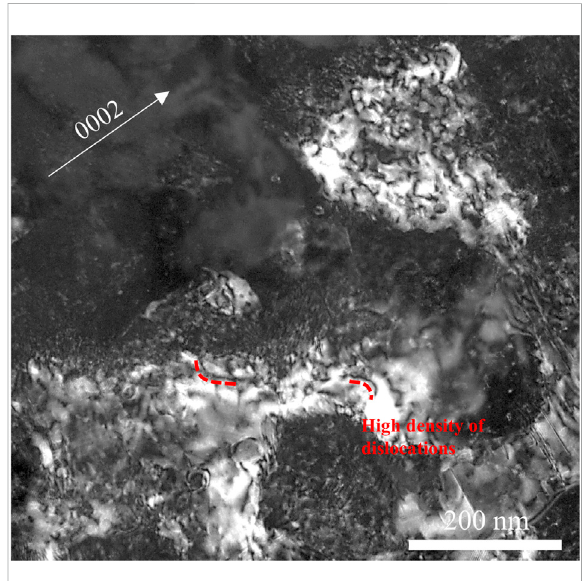
FIGURE 4 Bright- fi eld TEM imagedetected from theLT146-LSR sample under two-beam diffraction conditions of g = 0002.